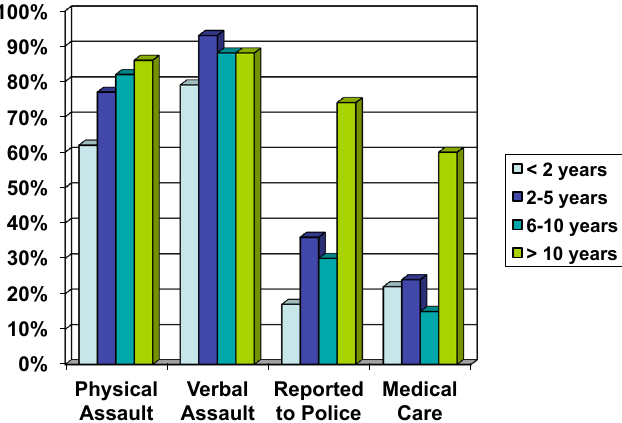
Figure 1. Percentage of assaults and safety behaviors by years of